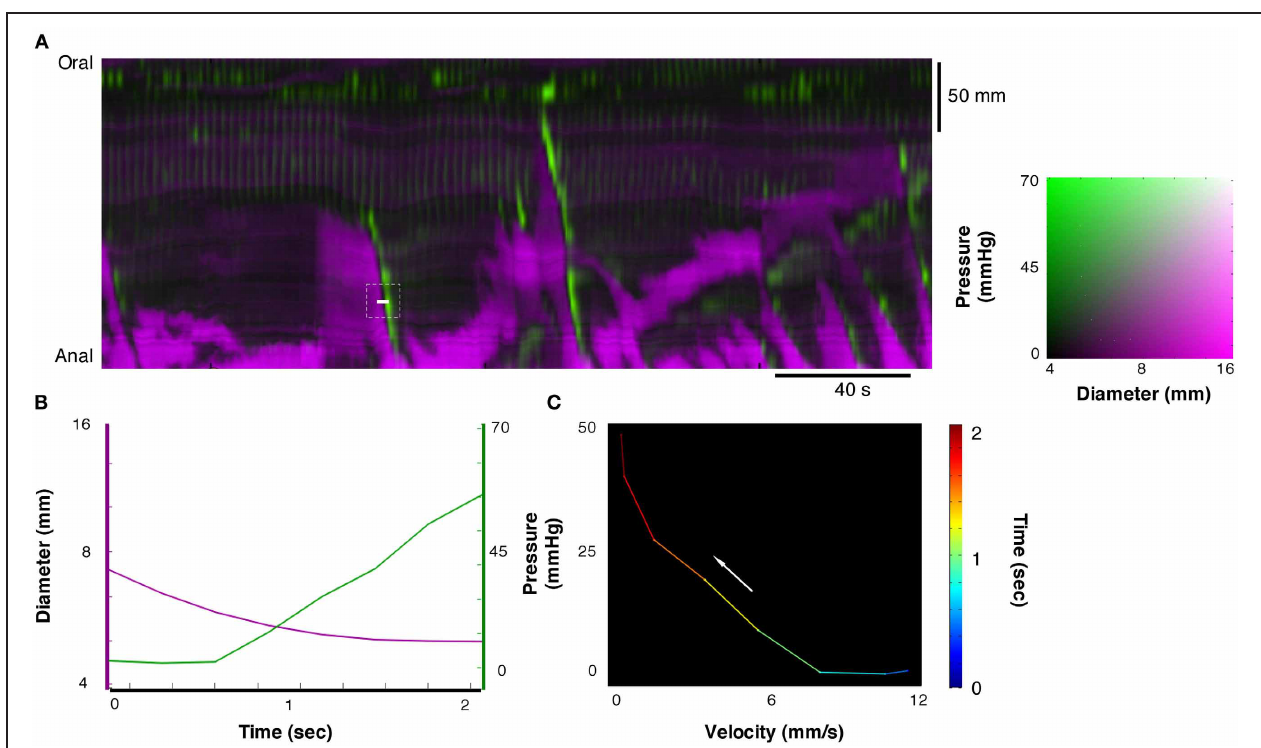
FIGURE 7 | From the composite DPMap (white line in A), traces of changes in diameter and pressure were extracted (B) from a short period. During this period a contraction started as isotonic and ended as isometric (C) . Such orbit of dynamic mechanical state corresponds